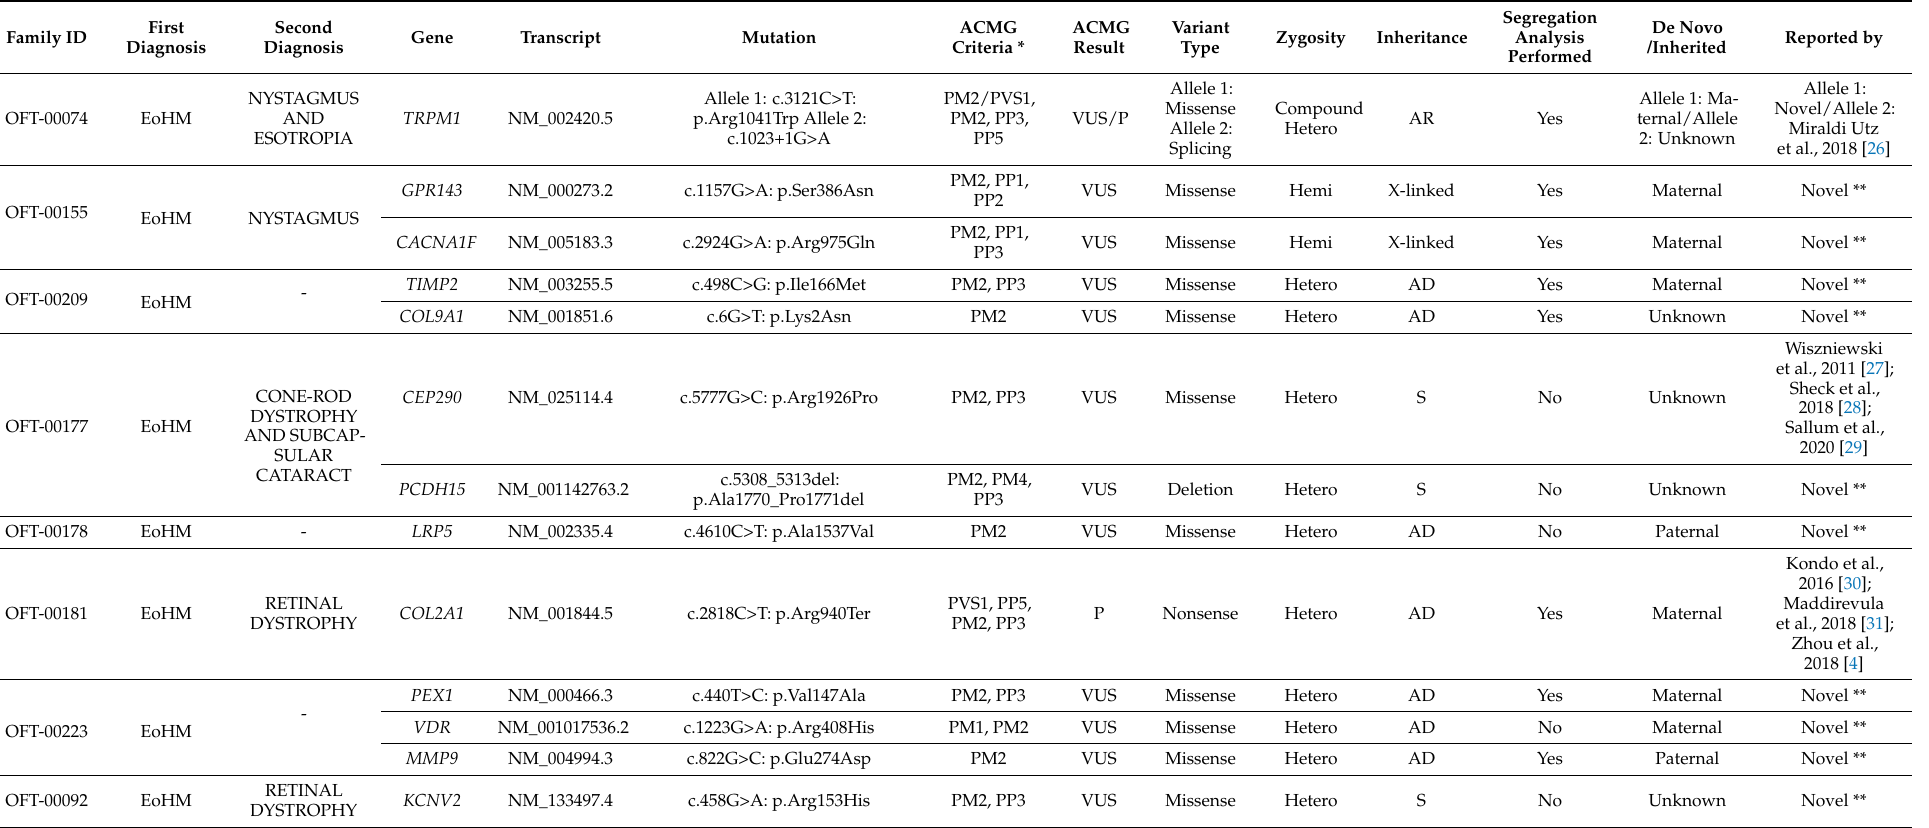
Table 3. Genetic Results of